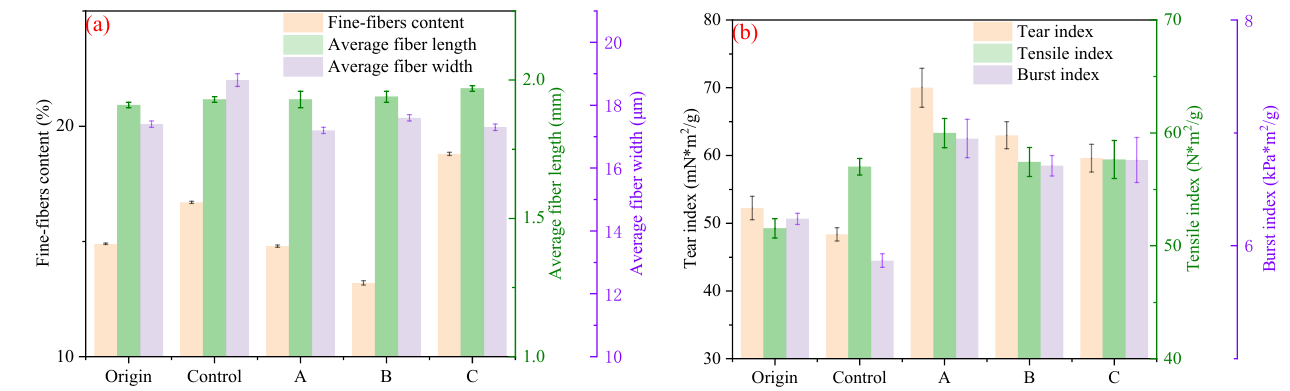
Figure 6. Fiber morphology and properties of hand papermaking of bamboo sulfate pulp (45°SR): ( a ) fiber morphology; ( b ) physical properties. A: hand-paper obtained from bamboo pulp A, B: hand-paper obtained from bamboo pulp B, C: hand-paper obtained from bamboo pulp C.